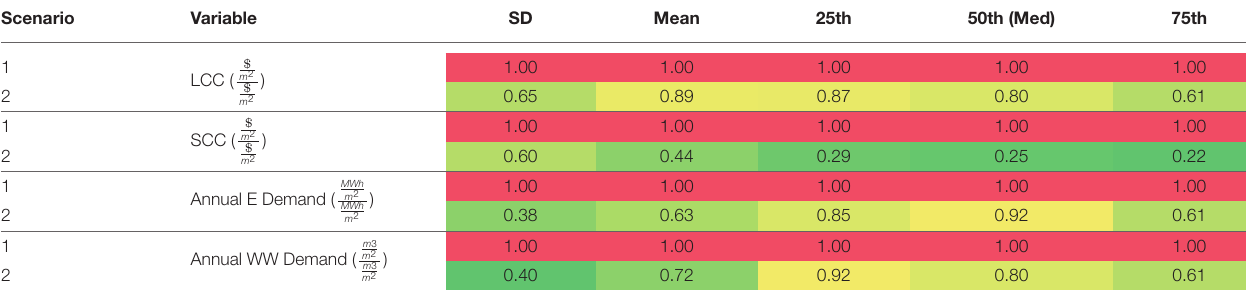
TABLE 5 | Statistical comparison between the results of scenario 1 (segregated) and scenario 2 (integrated). Scenario Variable SD Mean